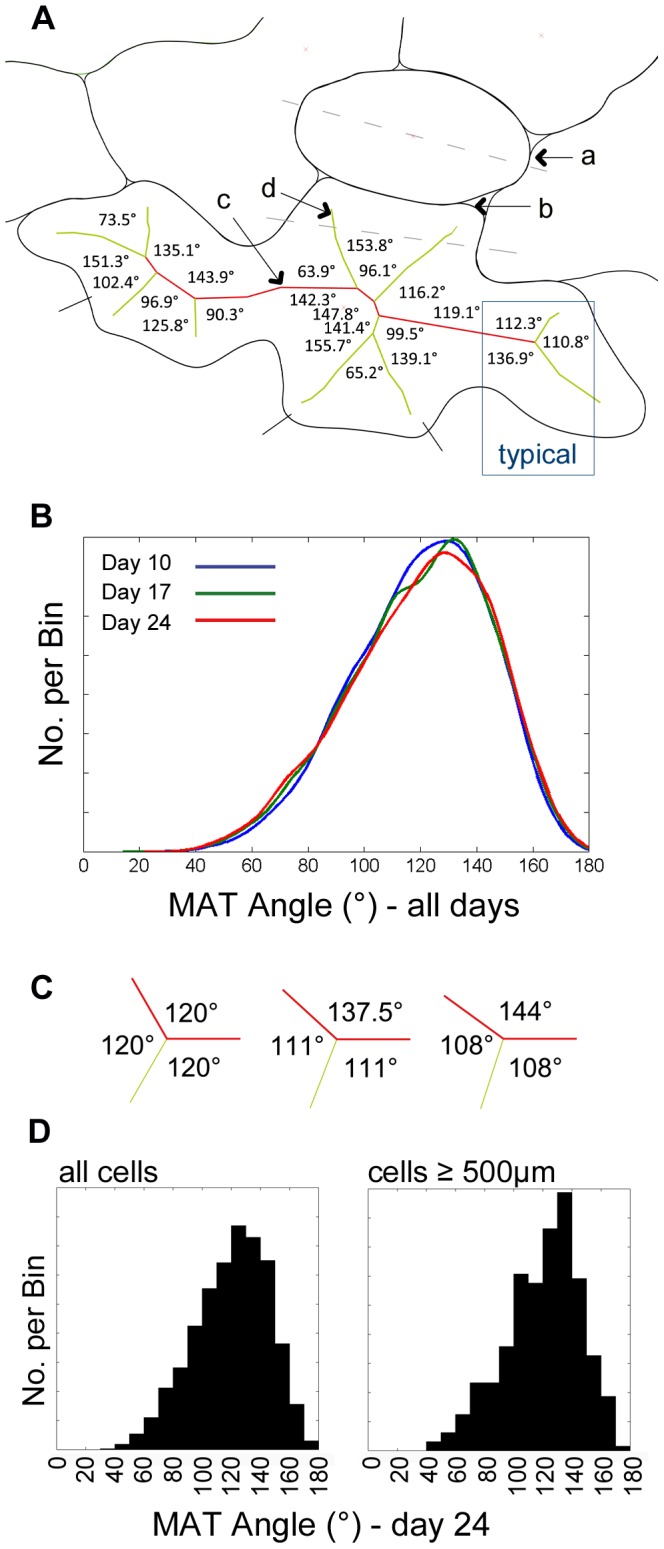
Medial Axis Transform (MAT) angles and distribution frequency.A Each cell outline was exported from AutoCAD into MATLAB using AutoLISP script. Here is the typical data extracted showing (a) stomatal pore axis; (b) cell boundary; (c) MAT internal segment lengths (red); and (d) external segment lengths (green). MAT angle measurements are also shown. B Graph shows the distribution curves of all angles along MAT at branch points for day 10 (blue), day 17 (green) and day 24 (red). The peaks all fall in the range 125–135°. C Possible angle subdivisions of 360°, e.g. golden angle plus two equal smaller angles would be 137.5°+111.25°+111.25°. Typical angle groupings found in our data set often exhibited such values, e.g. 144°+108°+108°. It is worth noting that the ratios of successive Fibonacci numbers converge on the golden ratio (137.5°) as n approaches infinity in the equation , where . D Histograms of MAT angles for all cells (left) and only cells of area ≥500 µm2 (right) for Day 24. Generally the peak is around 130°, but when the giant cells are isolated, the increased frequency is seen around 100–110° and 130–140°.